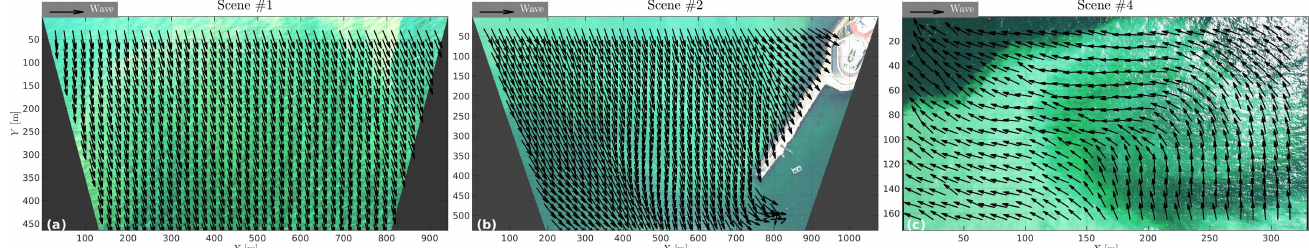
Figure 10. Wave direction field for ( a ) Scene #1; ( b ) Scene #2; and ( c ) Scene